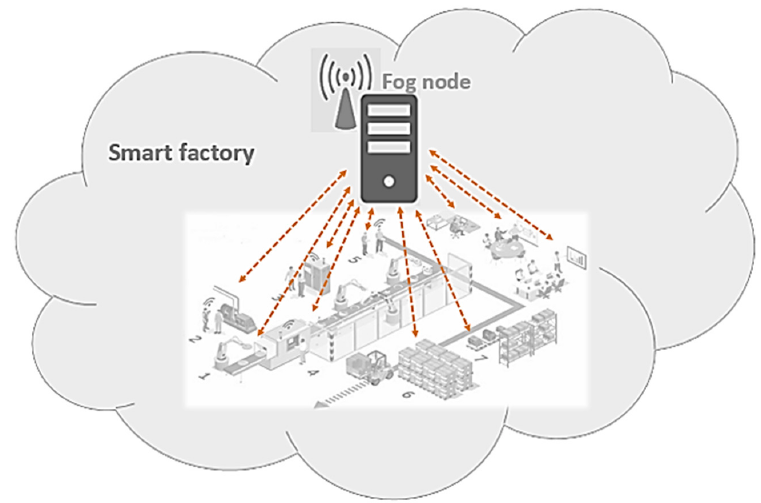
Figure 2. Smart factory as a smart city fragment.